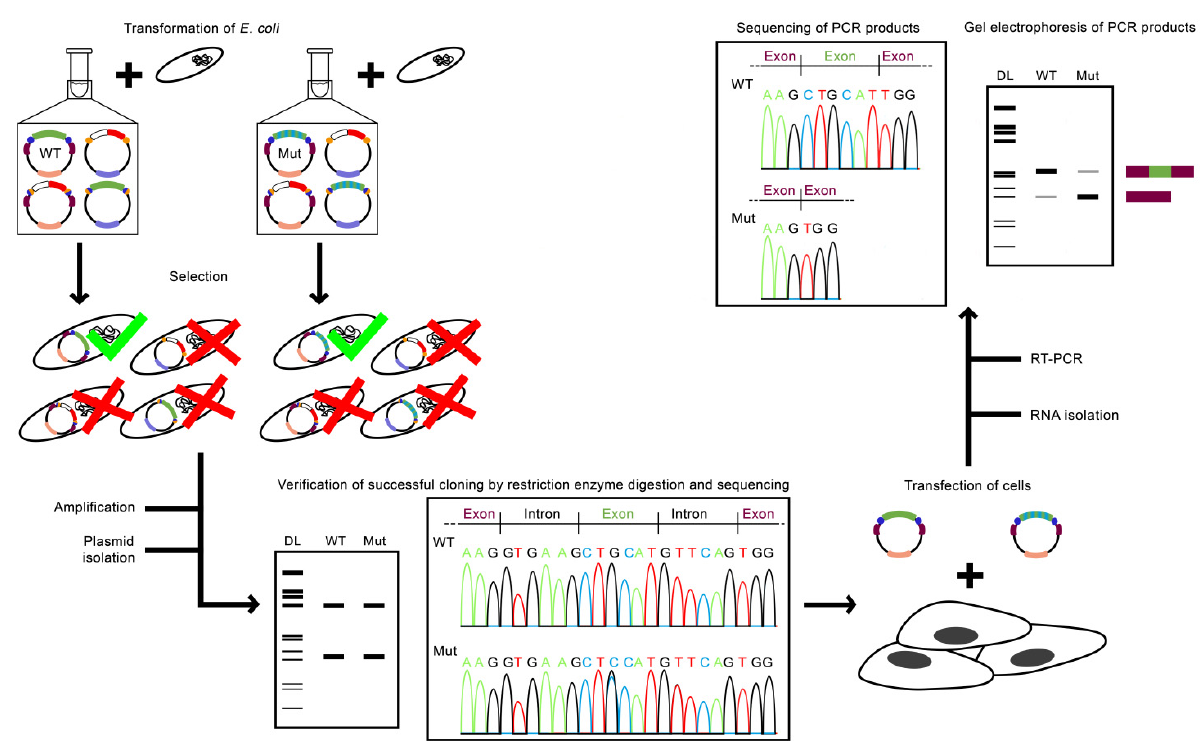
Figure 3. Typical workflow for assessing the impact of a genetic variant on splicing by minigene assay. Example Expression clones are shown, where two variants of a GFI are cloned into pDESTsplice. The variants of the Expression clone contain GFIs, which here represent two allelic variants of a SNP, one of them originating from a nucleotide substitution of G to C (WT: G, green box and Mut: C, green/light blue box). Constitutive splicing is expected for WT and alternative splicing for Mut. E. coli are transformed with a mixture containing the Expression clone, the by-product, pDESTsplice, and the Entry clone. For the components of the different vectors, the same color pattern as in Figure 2 was used. Bacteria containing WT and Mut are efficiently selected due to the ampicillin resistance gene and the ccdB gene. The selection is illustrated by green ticks (bacteria survive) and red crosses (bacteria cannot survive). The plasmid DNA is amplified and isolated. The verification of WT and Mut can be performed by restriction enzyme digestion and sequencing of extracted DNA bands. WT and Mut Expression clones are used to transfect cells. The transfected cells are incubated usually for 24 to 48 h before the RNA is isolated. The RNA is used for RT-PCR. The PCR products of WT and Mut are confirmed by gel electrophoresis and by sequencing. In the illustrated example, the Mut genotype leads to preferential skipping of the investigated exon. DL: DNA ladder, GFI: genomic fragment of interest, Mut: mutant, RT-PCR: reverse transcriptase polymerase chain reaction, WT: wild-type.